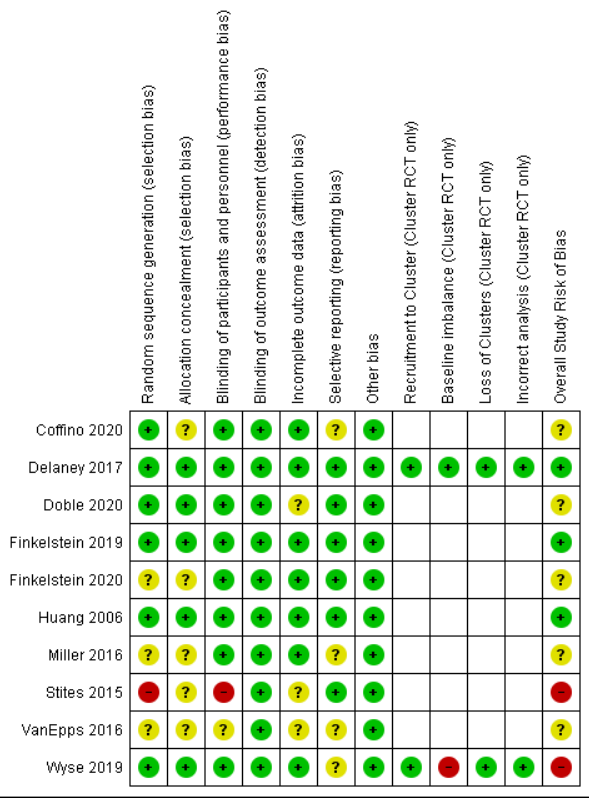
Figure 3. Effect of intervention delivered via online food ordering systems on the Energy content of purchases.